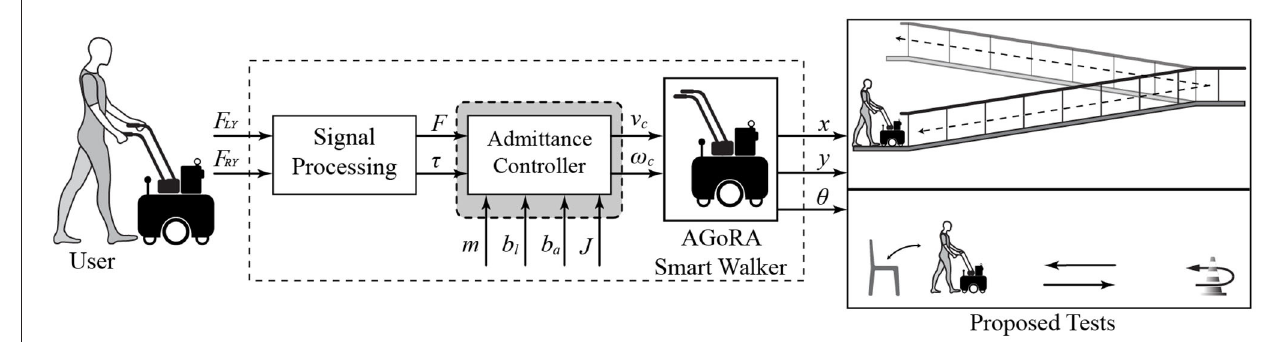
FIGURE 2 | Description of the system architecture implemented in this